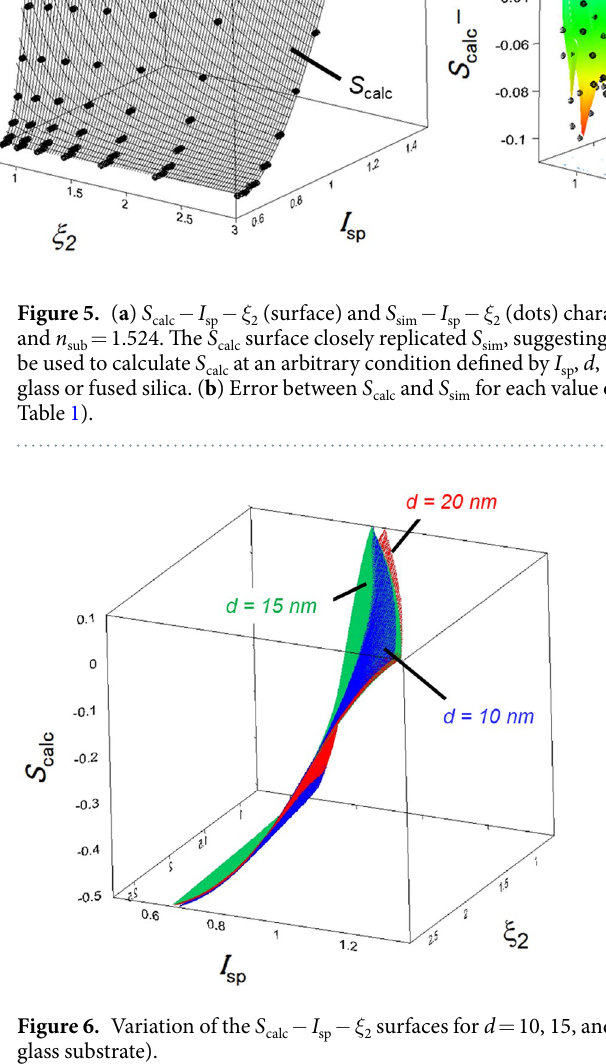
6 SCiEntifiC REPORTs | 7: 8405 | DOI:10.1038/s41598-017-08708-1